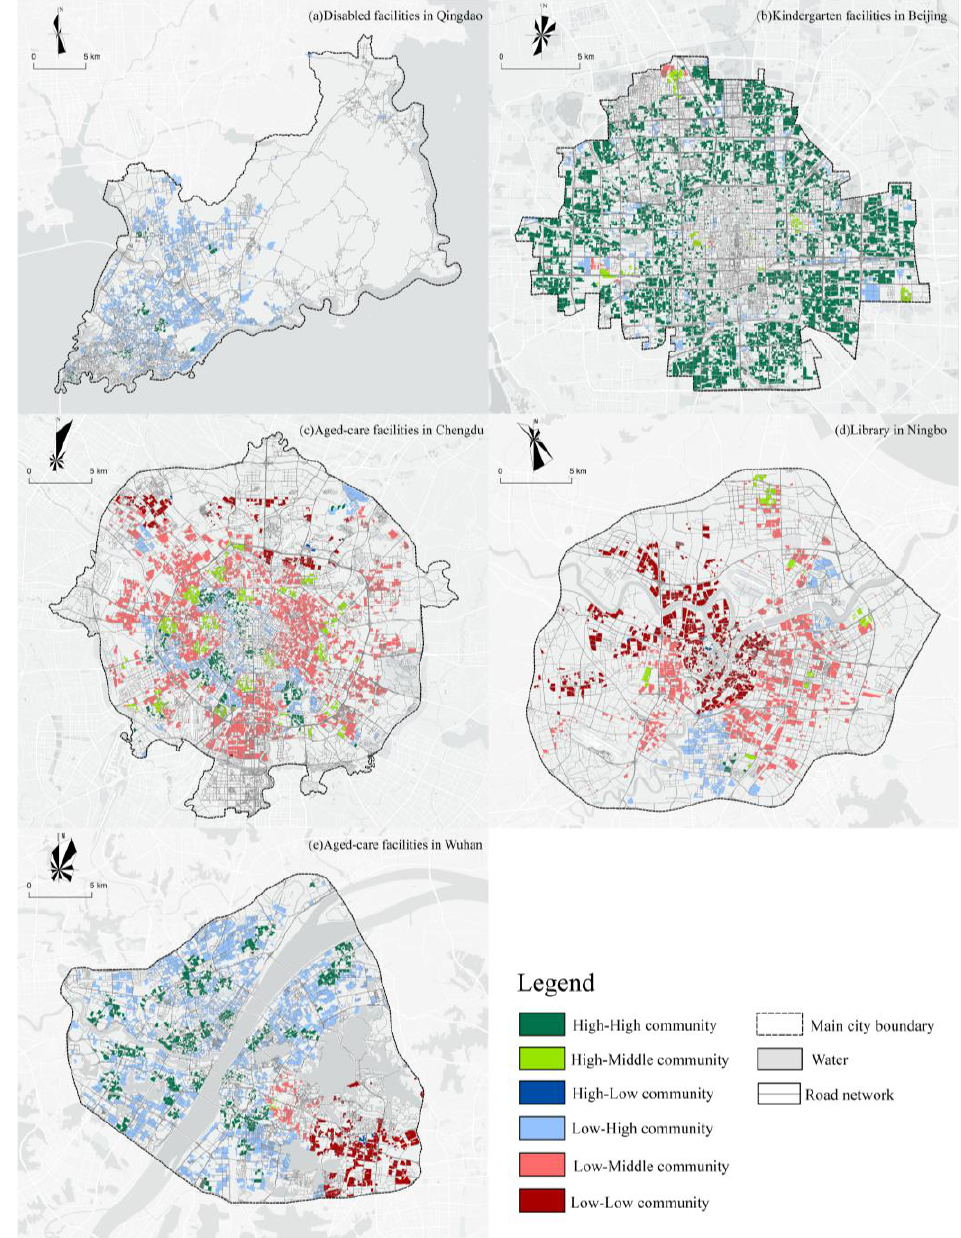
Figure 7. Representative cities of typical spatial distribution patterns of human settlements. ( a ) Stable tiling mode. ( b ) Gentle decline mode. ( c ) Undulating decline mode. ( d ) Central collapse mode. ( e ) Single-arm collapse mode.